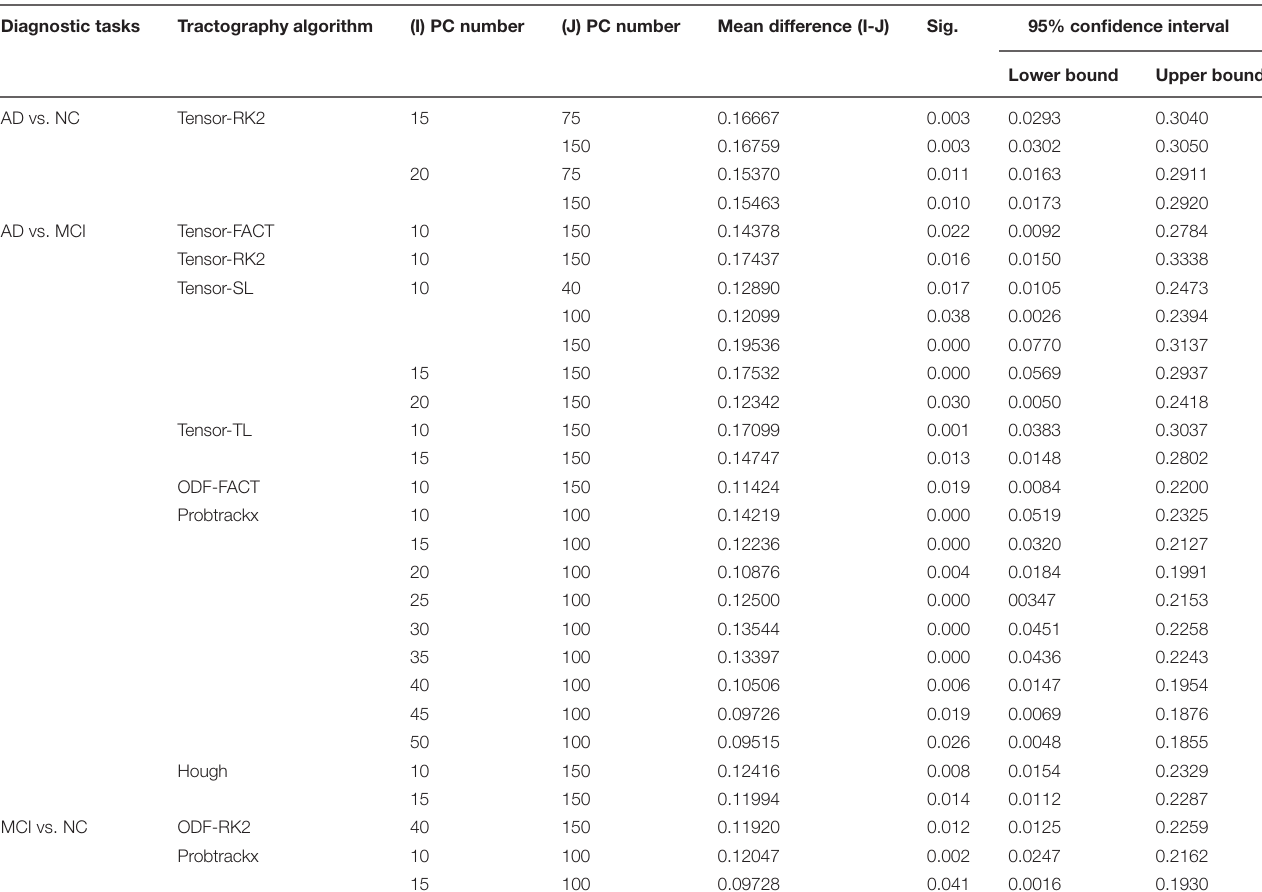
TABLE 5B | Post hoc comparisons